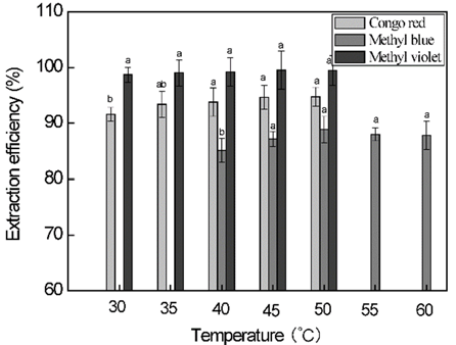
Figure 7. Effect of the temperature on the extraction efficiency of the dyes. (Each system contained 10 mL dyes solution (1 mg/mL CR, MB and 0.125 mg/mL MV), 4 mg Fe 3 O 4 @NH 2 , 4 wt. % TX ‐ 114, 20 min vibration time, and incubated at different temperatures for 10 min). Different letters in the same series indicate significant difference at p < 0.05 level.